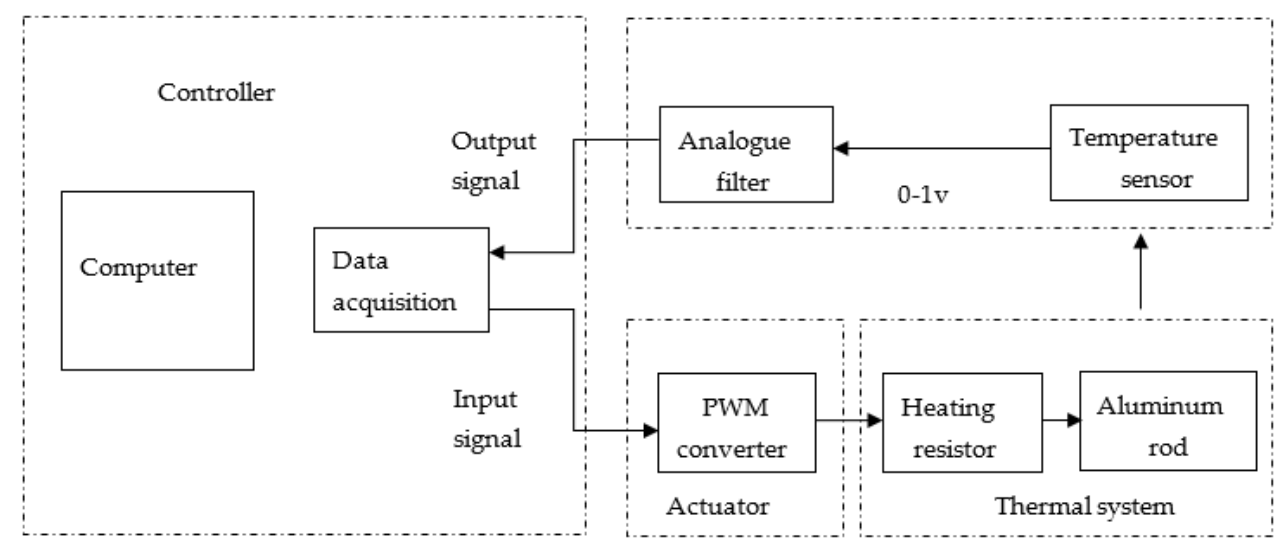
Figure 2. Illustrative diagram of thermal process.